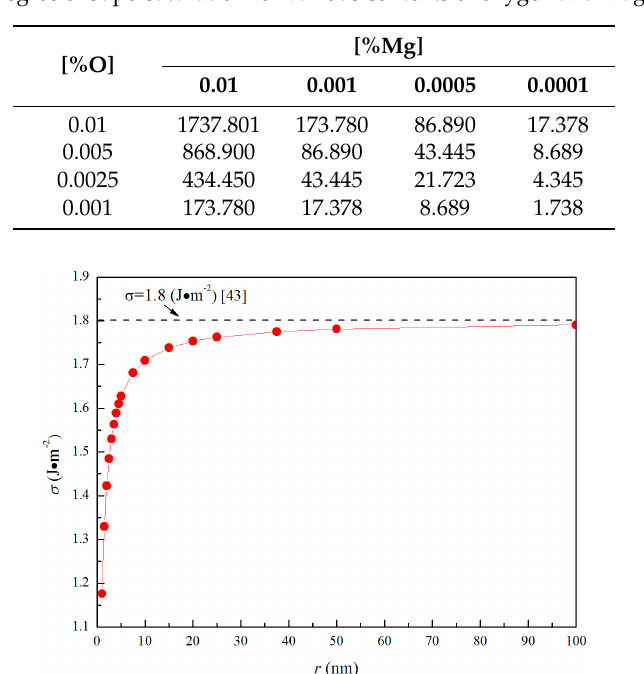
Table 2. Degree of supersaturation for various contents of oxygen and magnesium.